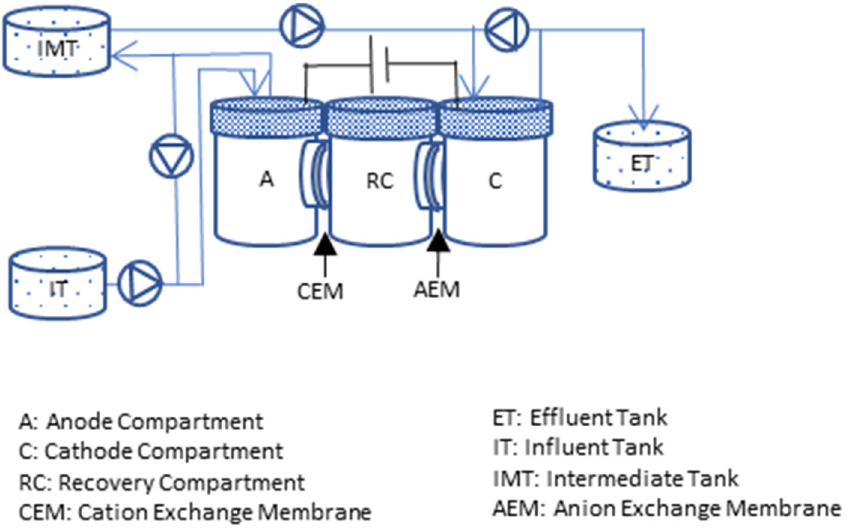
Figure 1. Scheme of the set ‐ up of the three ‐ chambered